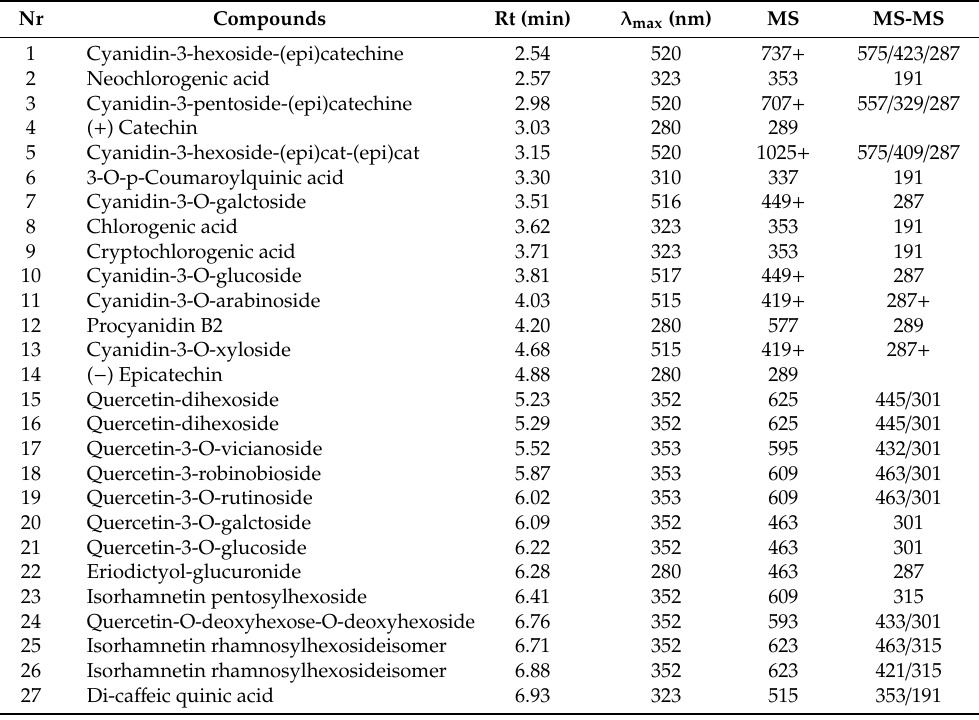
Table 4. Groups of polyphenolic compounds identified by LC-PDA-ESI-MS / MS in chokeberry